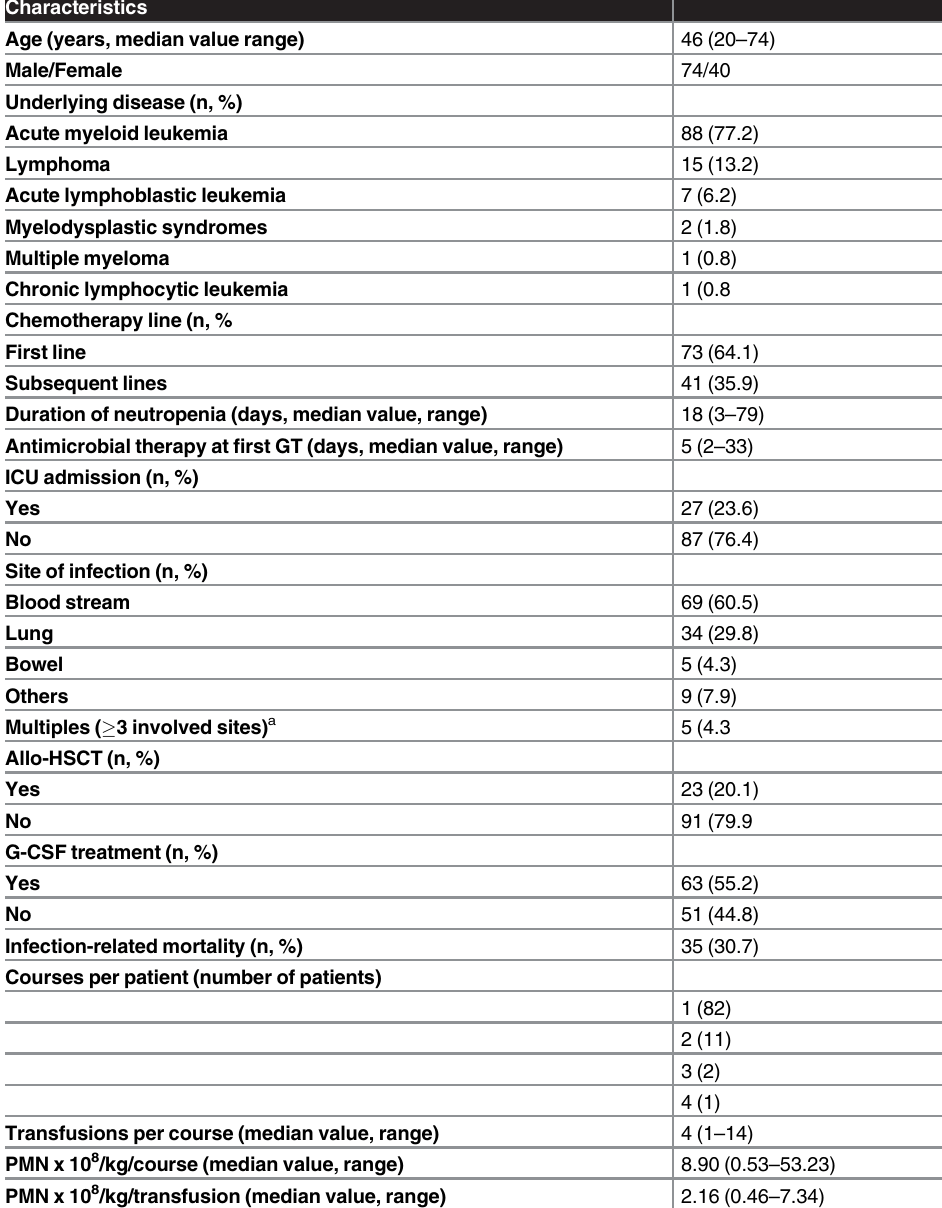
Table 1. Patient and granulocyte transfusion characteristics in 114 infective episodes.